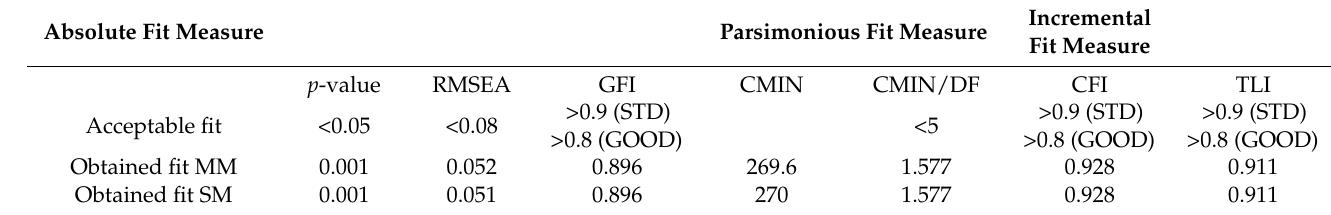
Table 8. Summary of fit